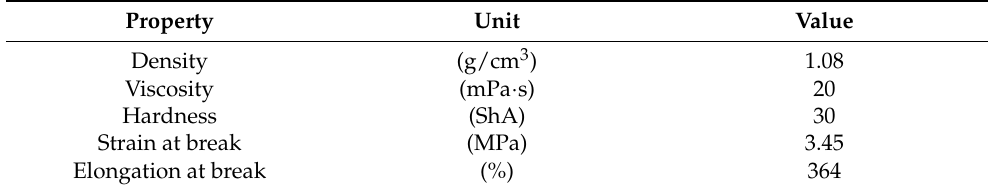
Table 1. Silicone properties [36].